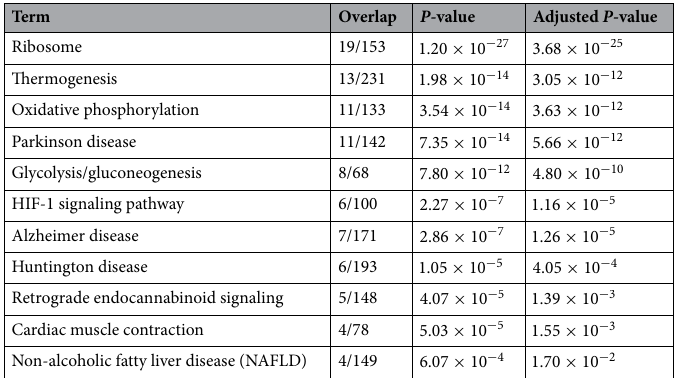
Table 1. “KEGG 2019 Human” category of Enrichr for 52 genes selected by applying PCA-based unsupervised FE to gene expression profiles. Eleven terms with adjusted P -values less than 0.05 are listed.